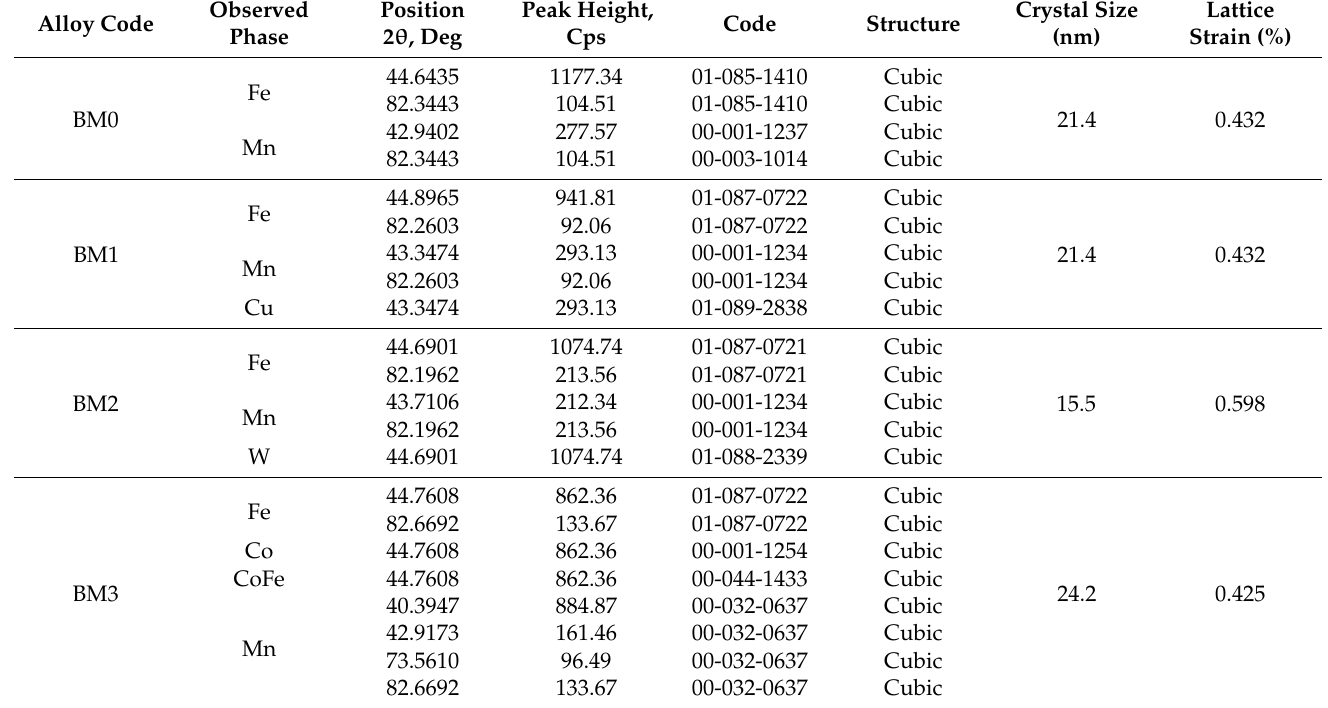
Table 2. The characteristics of the observed phases in MAed BM0, BM1, BM2, and BM3 alloys. Alloy